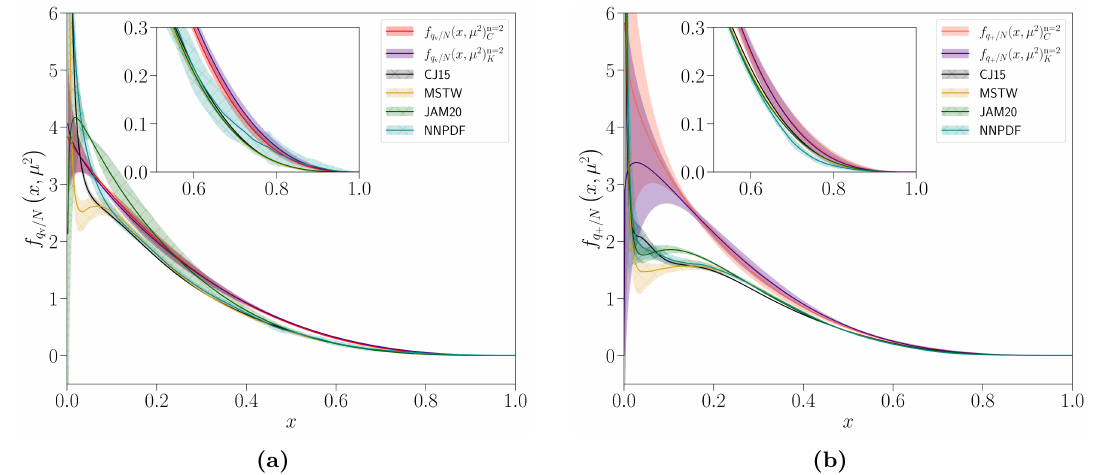
Figure 10. Two-parameter valence (a) and plus (b) quark PDF resulting from type- C (red) and type- K (indigo) fits to the unpolarized nucleon ITD and reduced pseudo-ITD, respectively. The direct matching fits are consistent with the cosine/sine transform of the model PDF fit to the ITD.